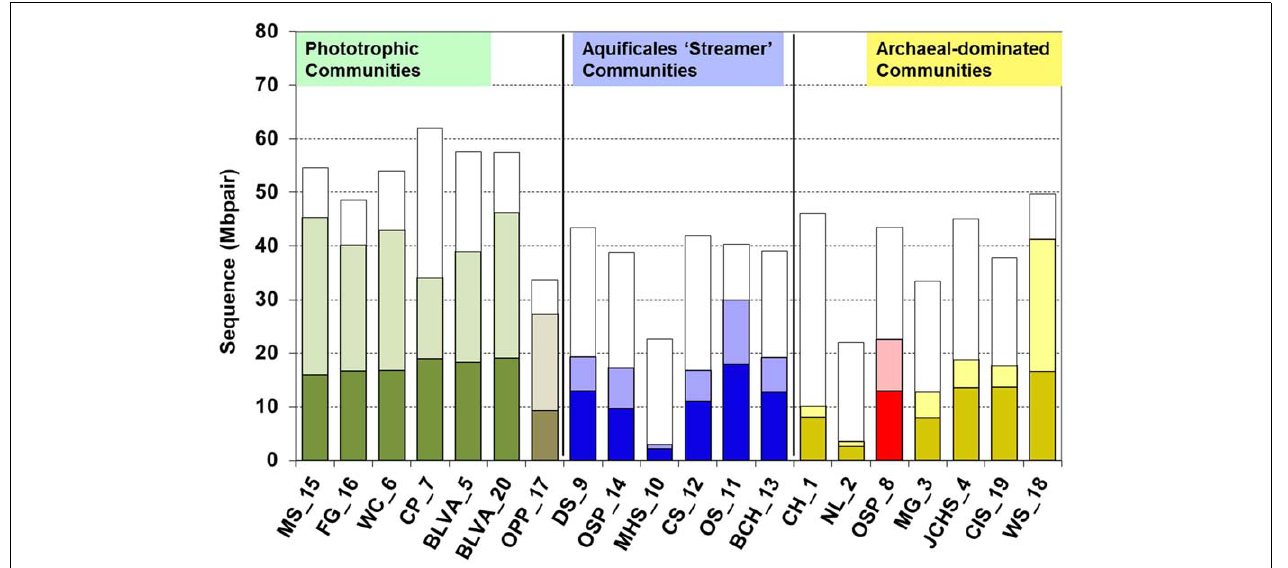
and light stacked bars, respectively [e.g., 62 Mbp of total sequence was obtained for CP_7, which resulted in 19Mbp of assembled sequence (total contig length) and ∼ 14Mbp of singleton